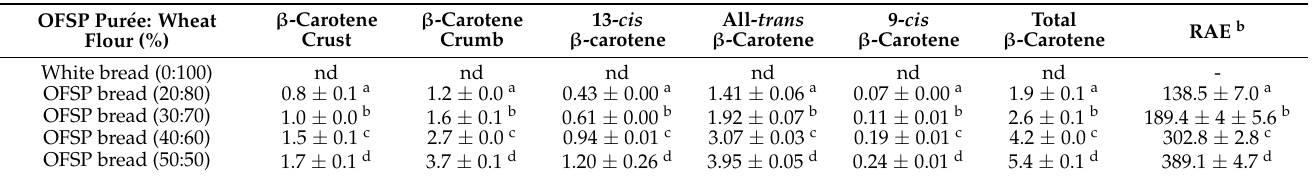
Table 3. Beta-carotene content (mg/100 g) and Retinol Activity Equivalents (RAE) ( µ g/100 g) in OFSP pur é e–wheat flour composite bread (DWB) 1 .